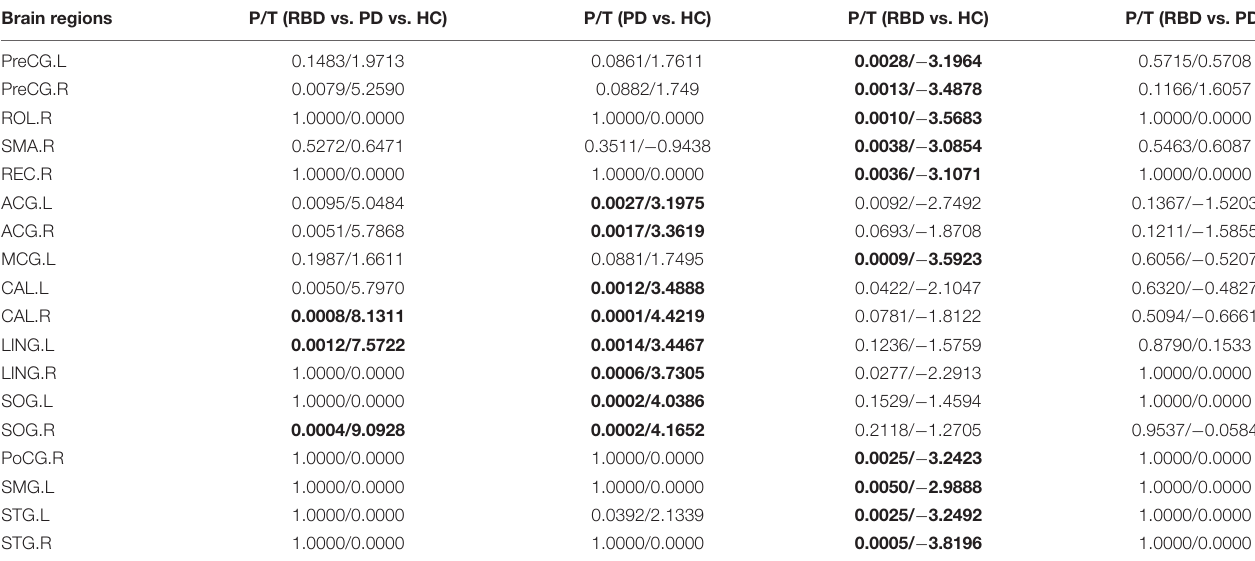
TABLE 4 | Alterations of Nodal Shortest Path among iRBD, PD, and HC. Brain regions P/T (RBD vs. PD vs. HC) P/T (PD vs. HC)